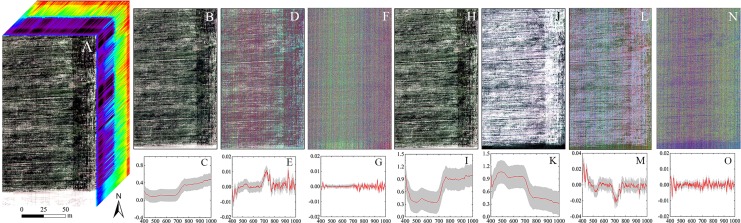
The hyperspectral imageries and spectral curves based on different pretreatments.(A) Hyperspectral image cube. (B) Image based on R. (C) Spectral curve based on R. (D) Image based on FDR. (E) Spectral curve based on FDR. (F) Image based on SDR. (G) Spectral curve based on SDR. (H) Image based on CR. (I) Spectral curve based on CR. (J) Image based on A. (K) Spectral curve based on A. (L) Image based on FDA. (M) Spectral curve based on FDA. (N) Image based on SDA. (O) Spectral curve based on SDA. The hyperspectral images and spectral curves based on different pretreatments (the red line represents the average spectrum and the gray region represents the standard deviation). The images are RGB images, where the red, green and blue bands are R659, R550, and R479, respectively.